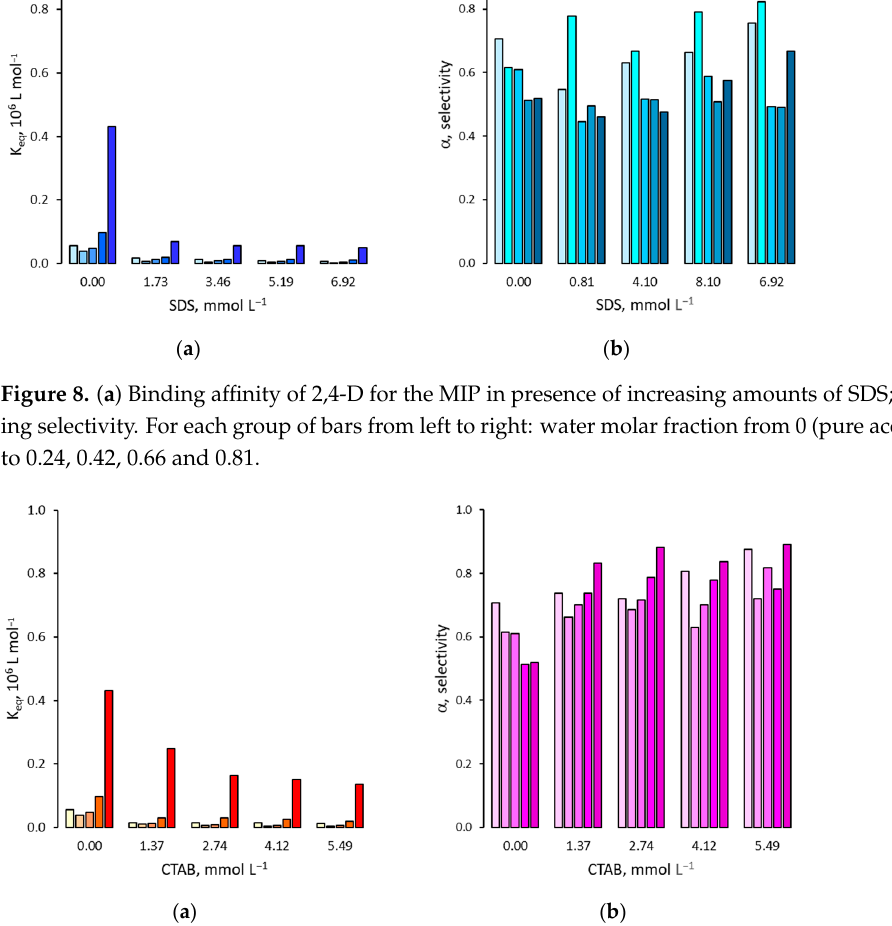
Figure 9. ( a ) Binding affinity of 2,4-D for the MIP in presence of increasing amounts of CTAB; ( b ) Binding selectivity. For each group of bars from left to right: water molar fraction from 0 (pure acetonitrile) to 0.24, 0.42, 0.66 and 0.81.